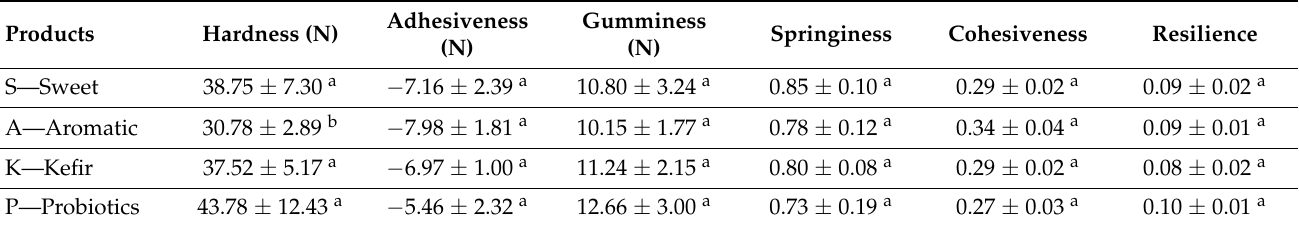
Table 4. Texture parameters of sheep’s butters produced with sweet cream and with cream fermented with different starter cultures. Average values and standard deviation ( ± ). Different superscript lowercase letters in each column (a,b) indicate significant differences ( p < 0.05) between